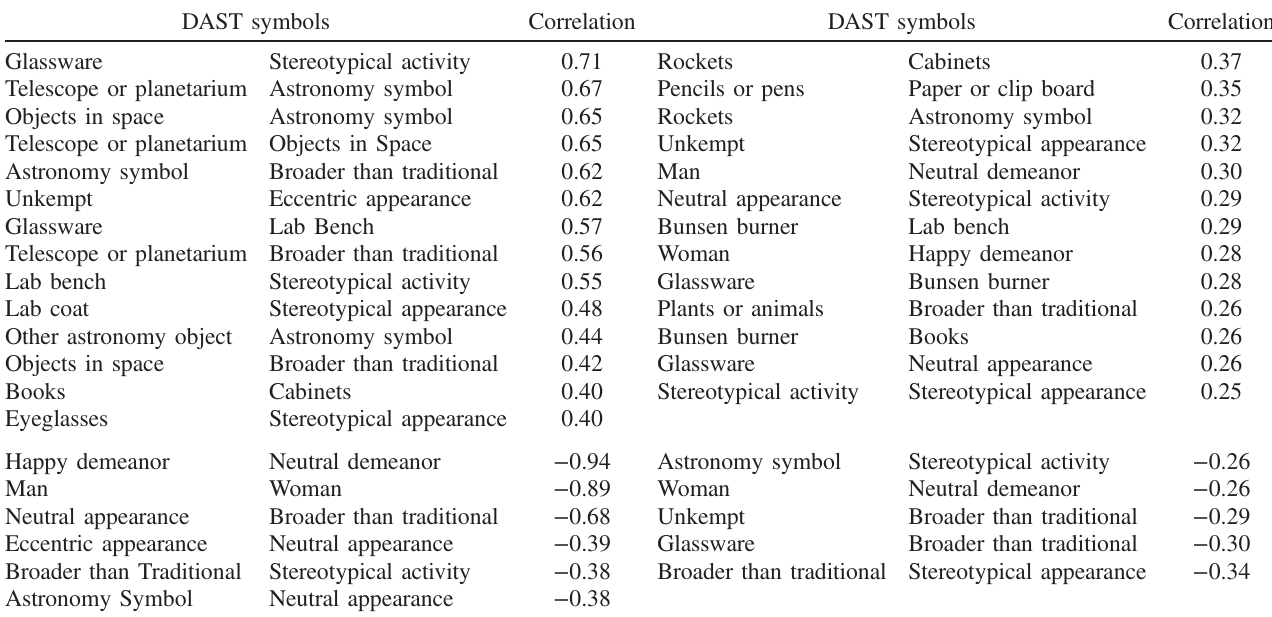
TABLE II. Correlation indices for pairs of symbols with correlation > 0 . 25 or correlation < − 0 . 25 . DAST symbols Correlation DAST symbols